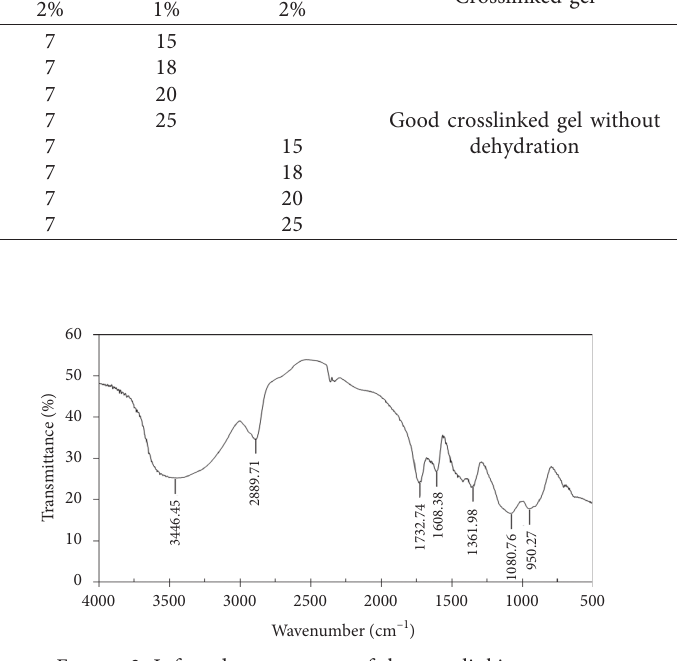
Figure 2: Infrared spectrogram of the crosslinking agent.